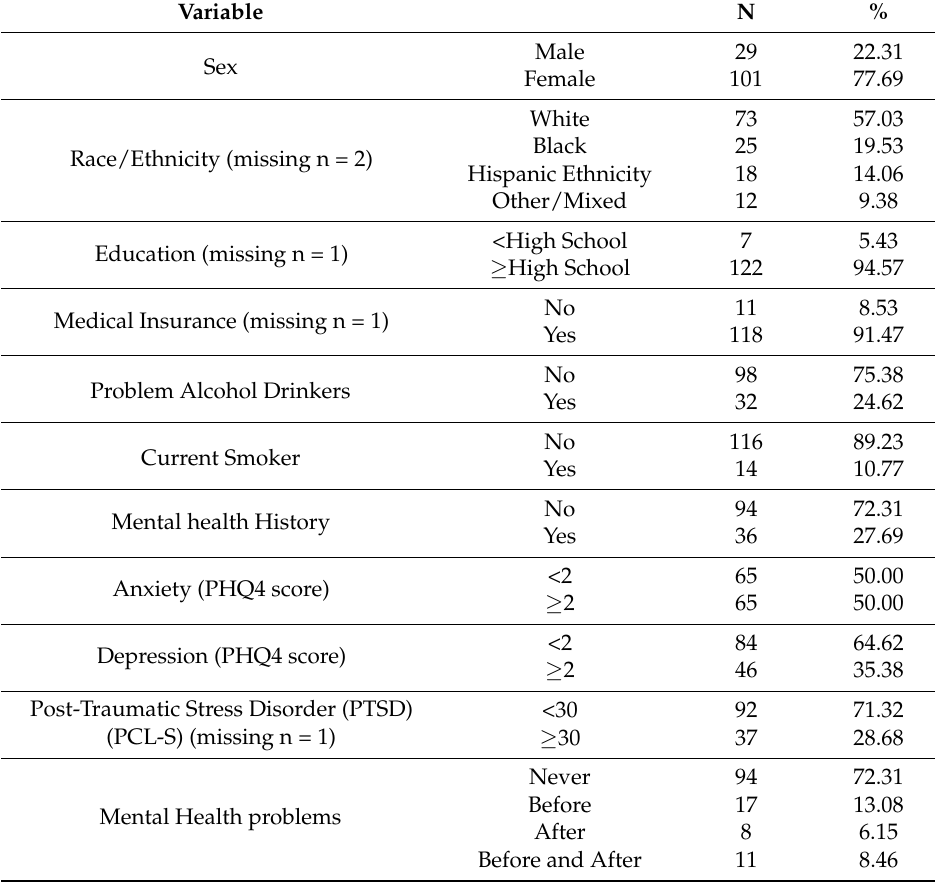
Table 1. Characteristics of the study population at